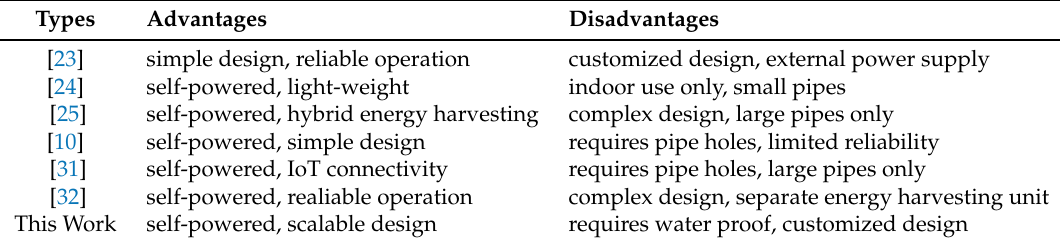
Table 5. Comparison of smart water meters.